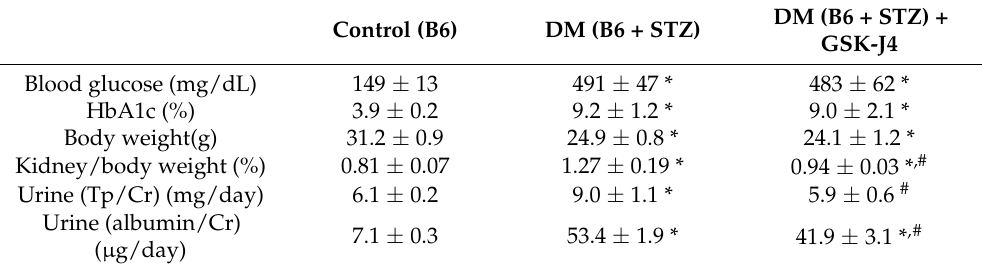
Table 1. Biochemical properties.